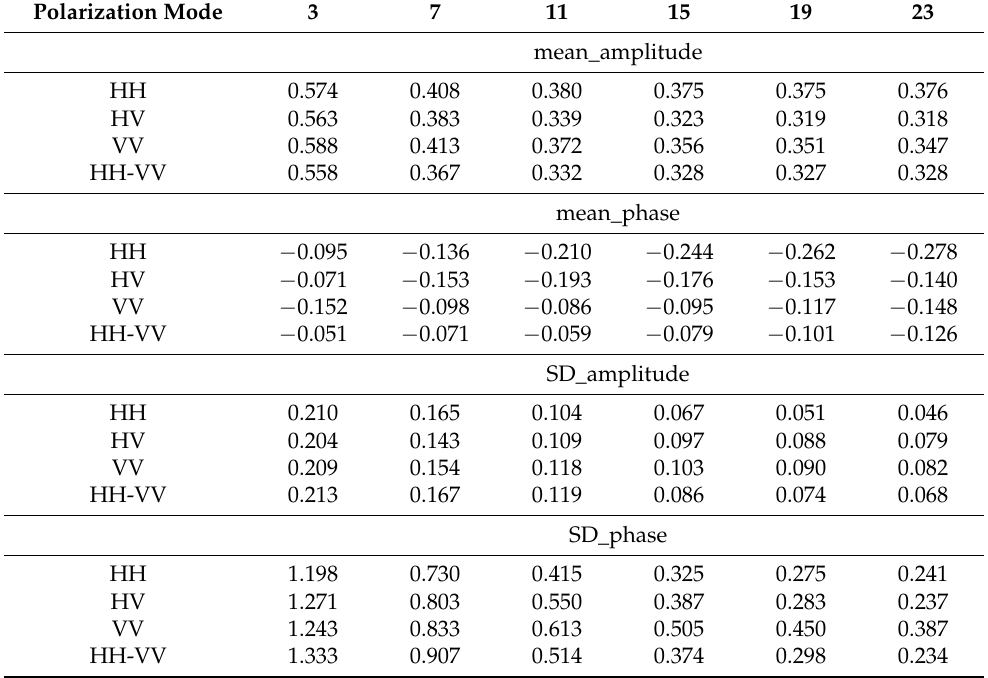
Table 3. The mean and standard deviation (SD) of coherence amplitude and phase for different statistical window size in 73–75 (H: Horizontal; V: Vertical).